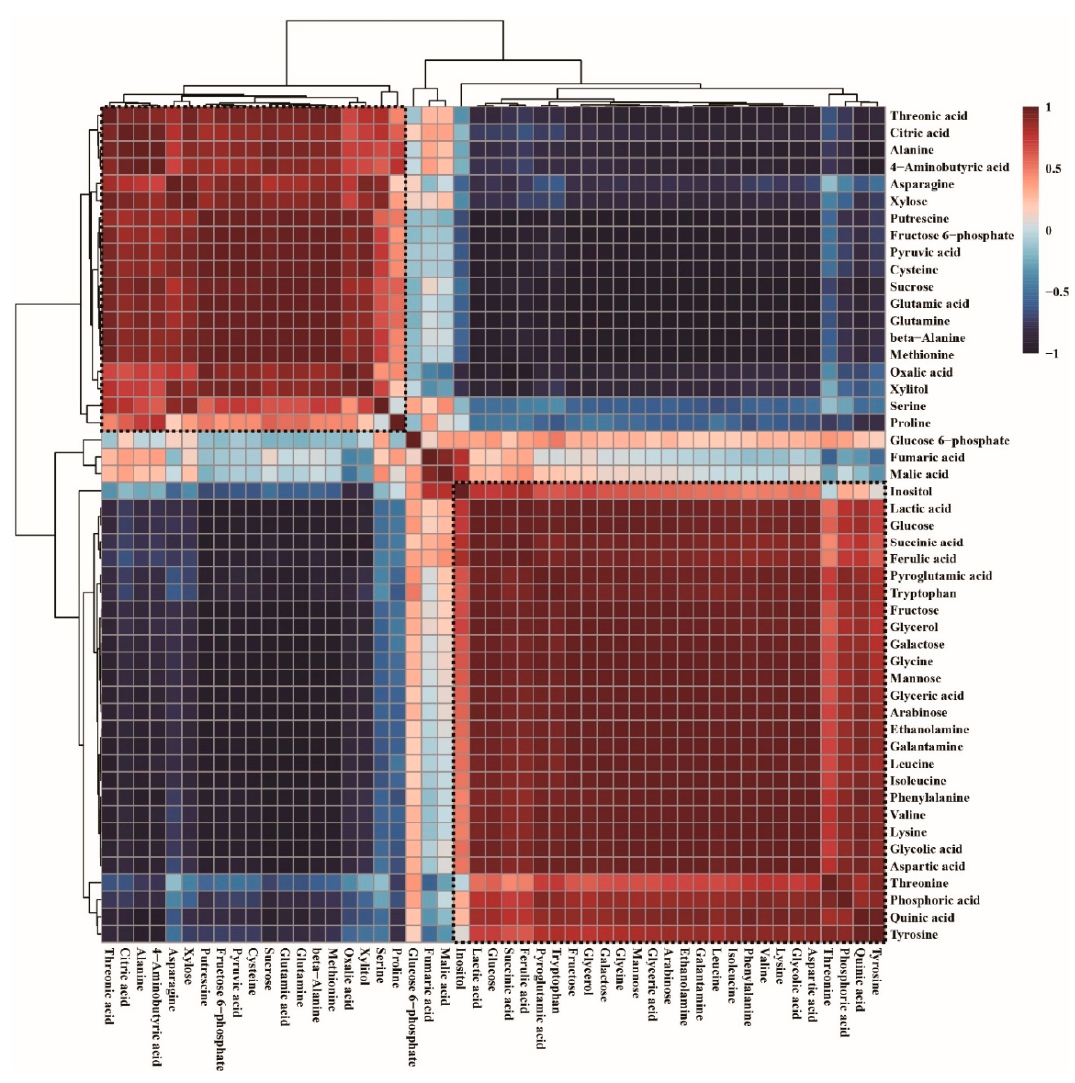
Figure 5. Correlation matrix-based hierarchical cluster analysis of results obtained from data of 49 metabolites between calli exposed for 0 and 96 h. Each square shows the Pearson’s correlation coefficient for a pair of metabolites, and the value for the correlation coefficient is displayed by the color difference, as shown on the color scale. Hierarchical clusters are characterized by a cluster tree.